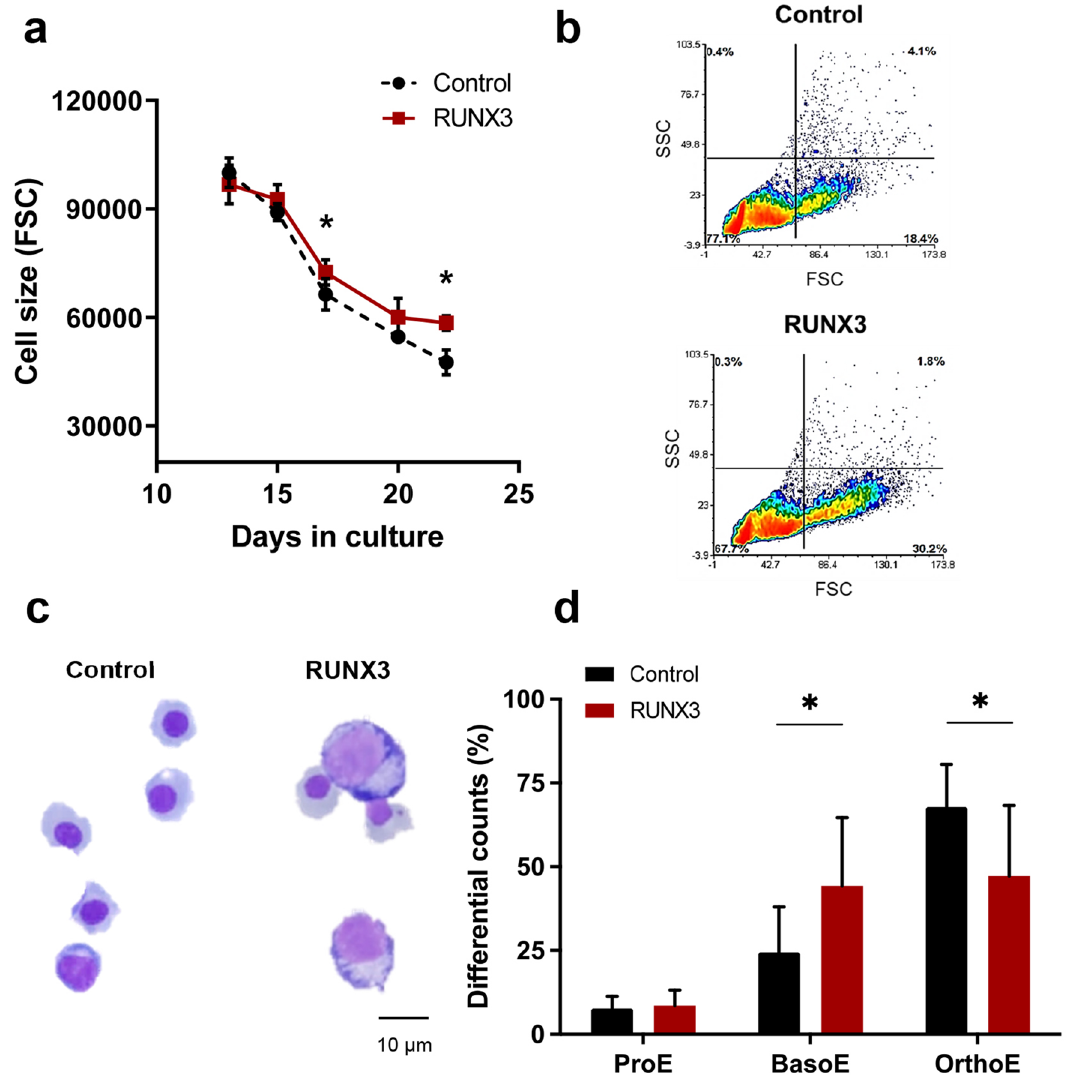
Figure 4. RUNX3 overexpression inhibits terminal erythroid differentiation. ( a ) Summary plot showing cell size assessed by flow cytometry (forward scatter, FSC). HSPC were initially cultured with IL-3, IL-6 and SCF for 10 days followed by addition of EPO at day 10. ( b ) Representative bivariate density plots of side scatter (SSC) vs FSC in control and RUNX3 cultures on day 22 of erythroid development. ( c ) Control and RUNX3-expressing cells analysed on day 20 of differentiation with May-Grünwald-Giemsa. ( d ) Differential morphology counts of cells categorised into ProE (proerythroblasts), BasoE (basophilic erythroblasts) and OrthoE (orthochromatic erythroblasts). Data indicate mean ± 1SD (n = 5). Significant difference of RUNX3-expressing cells from controls was analysed by paired t-test, * p <